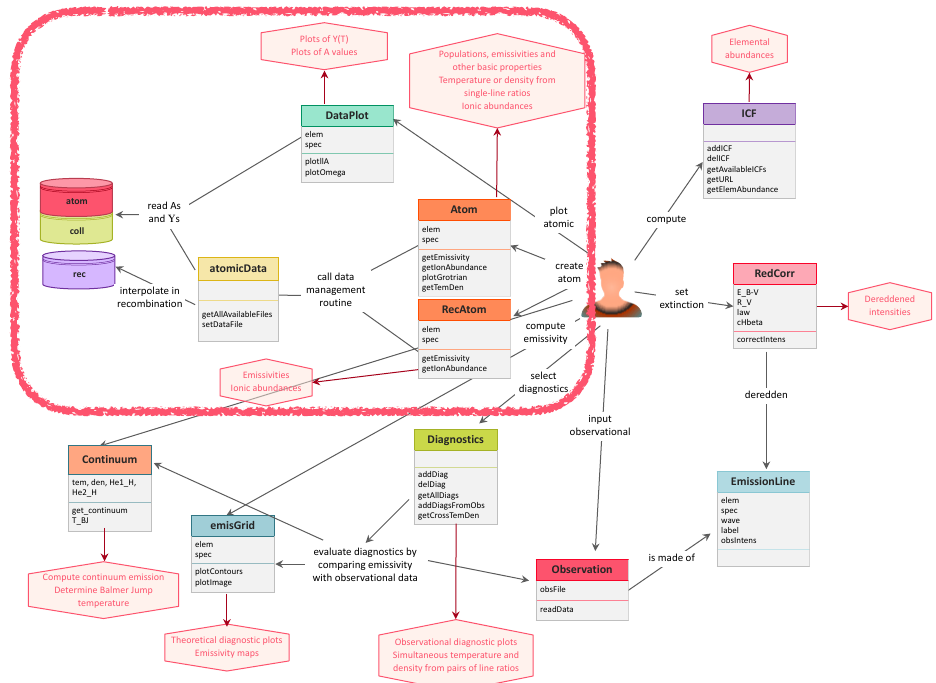
Figure 1. Outline of the PyNeb object-oriented architecture showing its classes (name, some arguments, and methods) and output products. For atomic data assessment, we employ the classes and data within the red rectangle. The new Continuum class (added in Version 1.1.9) computes the nebular continuum (considering two-photon, free–free, and free–bound emission processes) and the electron temperature associated with the Balmer or Paschen